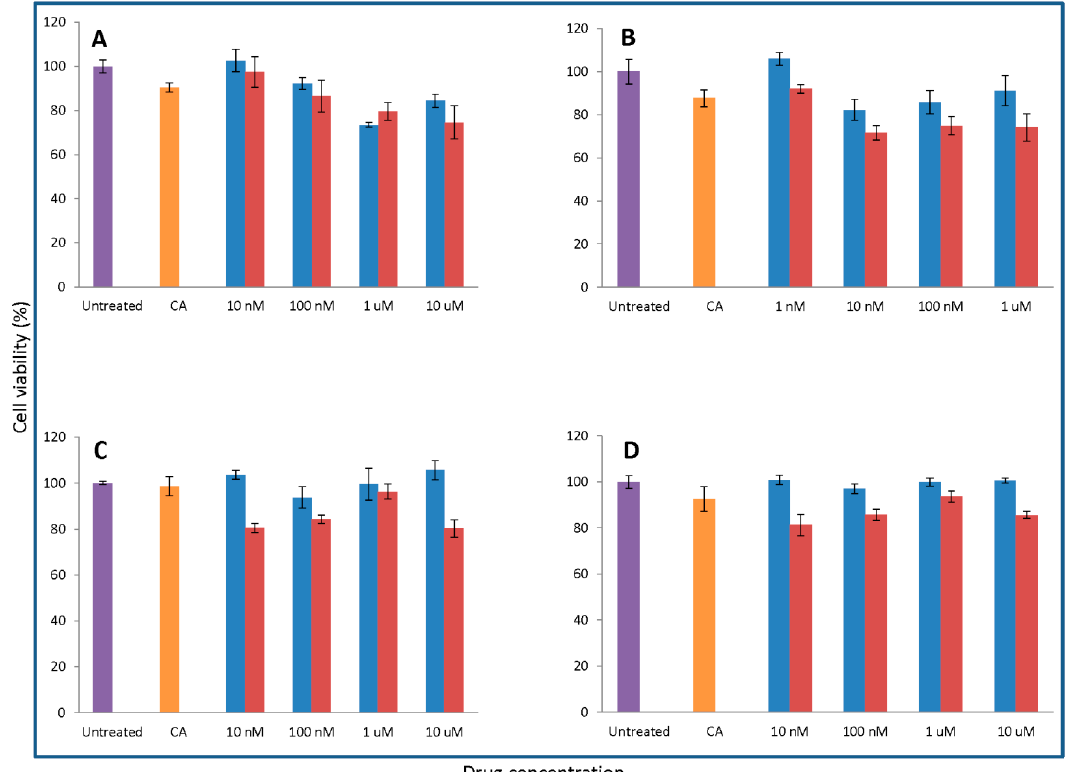
Figure 7. 4T1 Cells were seeded on 24-well plates at 5 × 10 4 cell/mL. After 24 h cells were treated with media or free drug or apatite/drug; 1 nM to 1 μ M of Doc ( B ) and 10 nM to 10 μ M of Pac ( A ), Mito ( C ), and Topo ( D ) were used for the treatment. Apatite was formed in the presence of the aforementioned drug concentrations using 3 mM CaCl 2 for Doc and Topo and 4 mM CaCl 2 for Pac and Mito. After 44 h of treatment cell viability was measured by MTT assay. Values were represented as the percentage of cell viability compared to media and apatite as the control for free drug and apatite/drug, respectively. Data presented as mean ± SD. ● Untreated, ● CA treated, ● Free drug treated, ● CA/drug treated.